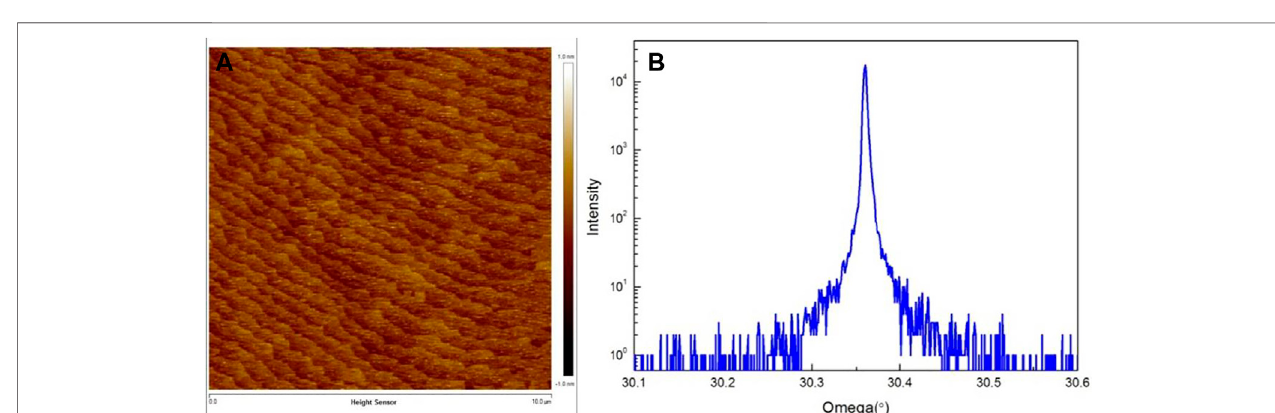
FIGURE 9 | (A) AFM image and (B) HRXRD rocking curve of a GaSb buffer layer.